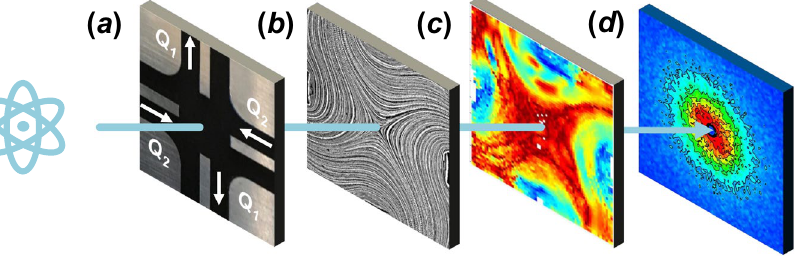
Figure 2. Schematic outline of FFoRM-SANS workflow. ( a ) The parameterized FFoRM geometry is adjusted to generate spatially uniform flows within design constraints. Flow field visualization enables the operational mapping of the ( b ) streamlines and ( c ) flow type/deformation rate field the fluid experiences. ( d ) Small-angle neutron scattering probes structural changes in the material under arbitrary deformation